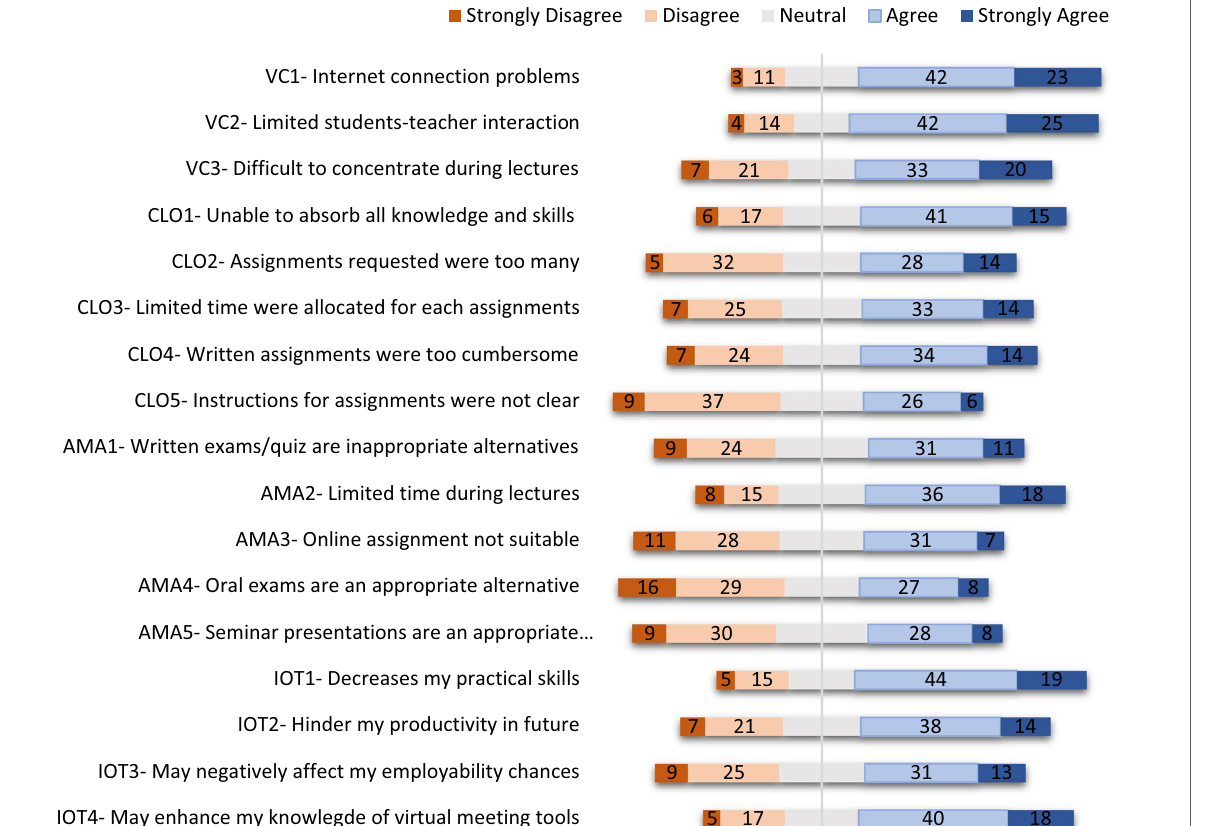
Fig. 1 Diverging stacked bar chart showing results in percentage (%) from the five-point Likert scale student-targeted questionnaire ( n Responses were collected in four categories: virtual classrooms (VC), course learning outcomes (CLO), alternative method of assessment (AMA) and impact of online teaching (IOT). The complete statements from the questionnaire are available in Additional file 1: Table